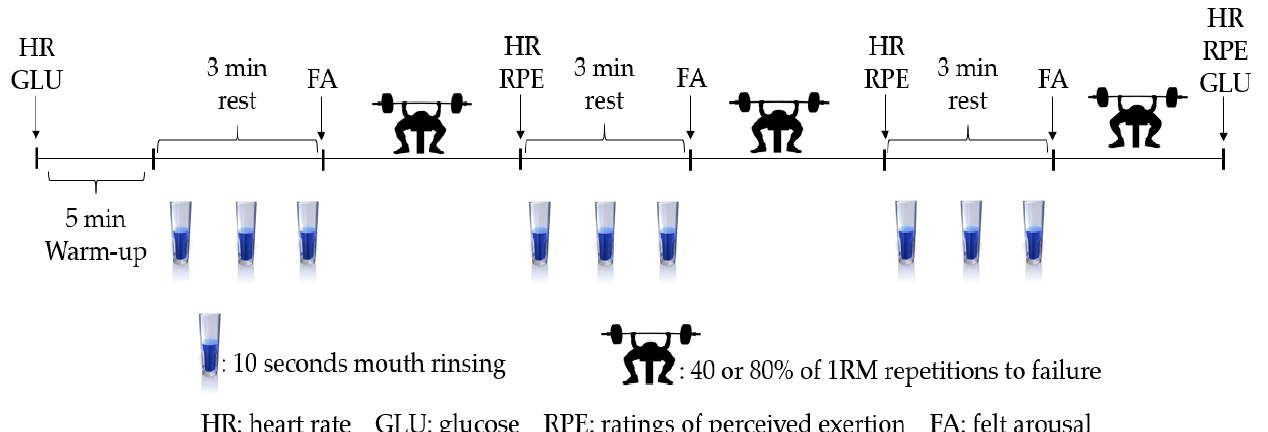
Figure 1. Schematic diagram of experimental